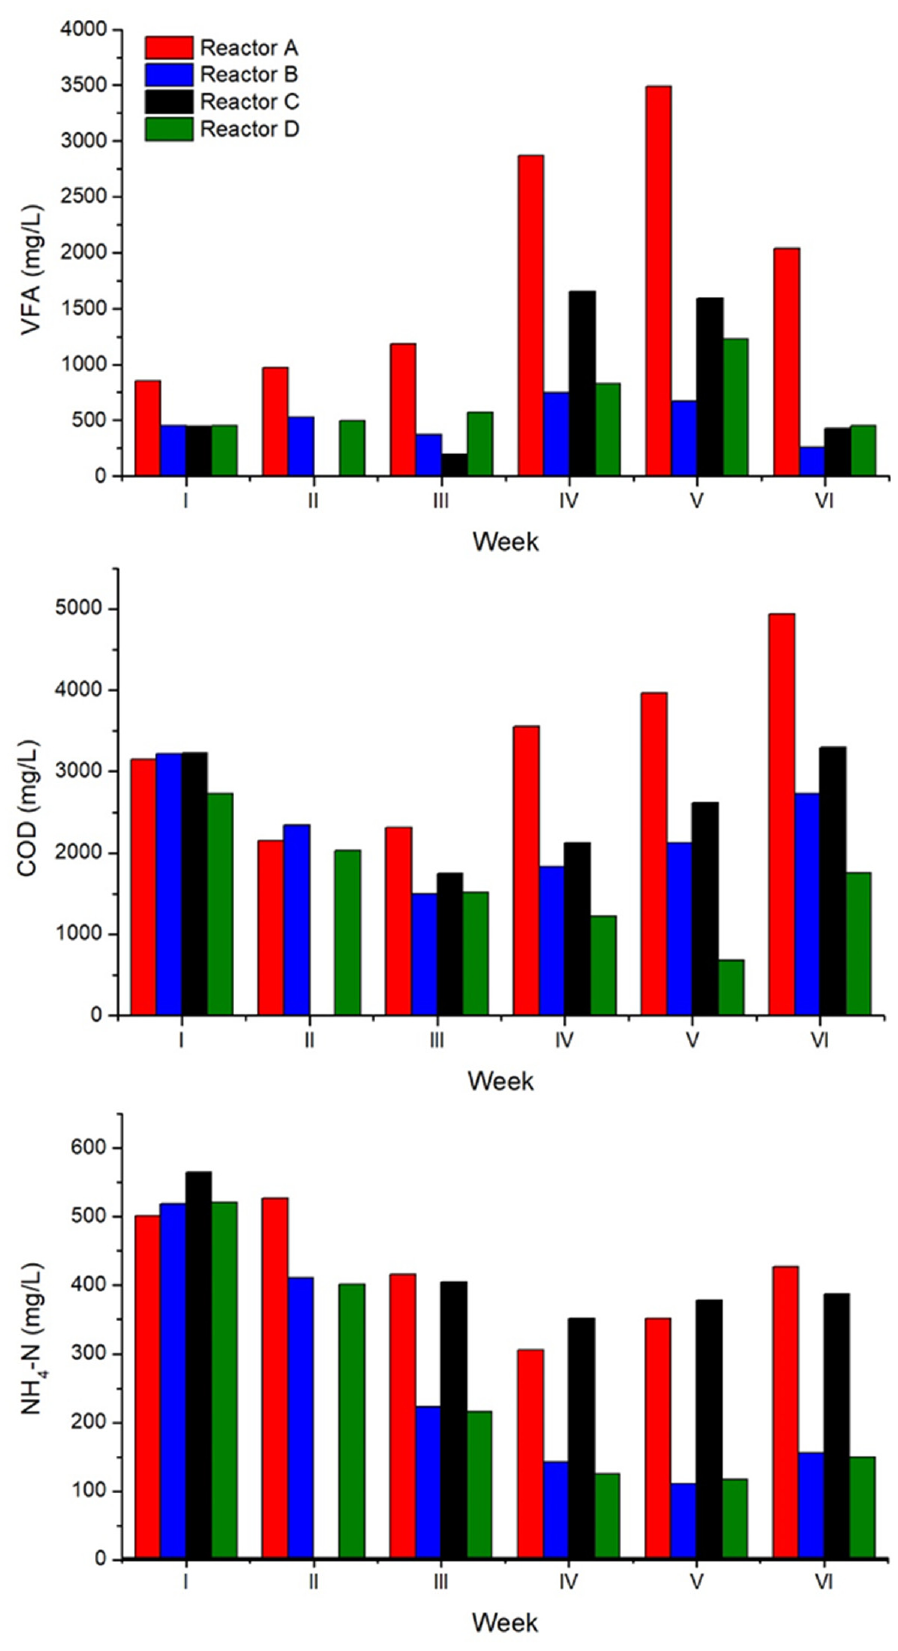
Figure 3. VFAs, COD, and NH 4 -N contents in weekly collected digestates.